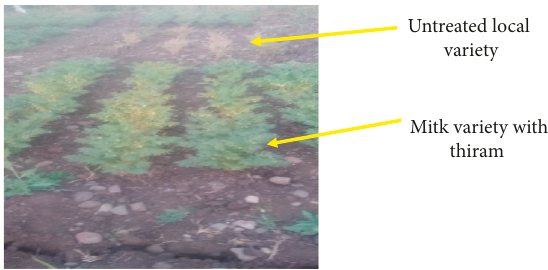
Figure 2: Thiram-treated Mitk variety and untreated local variety at Lalibella zuria district.